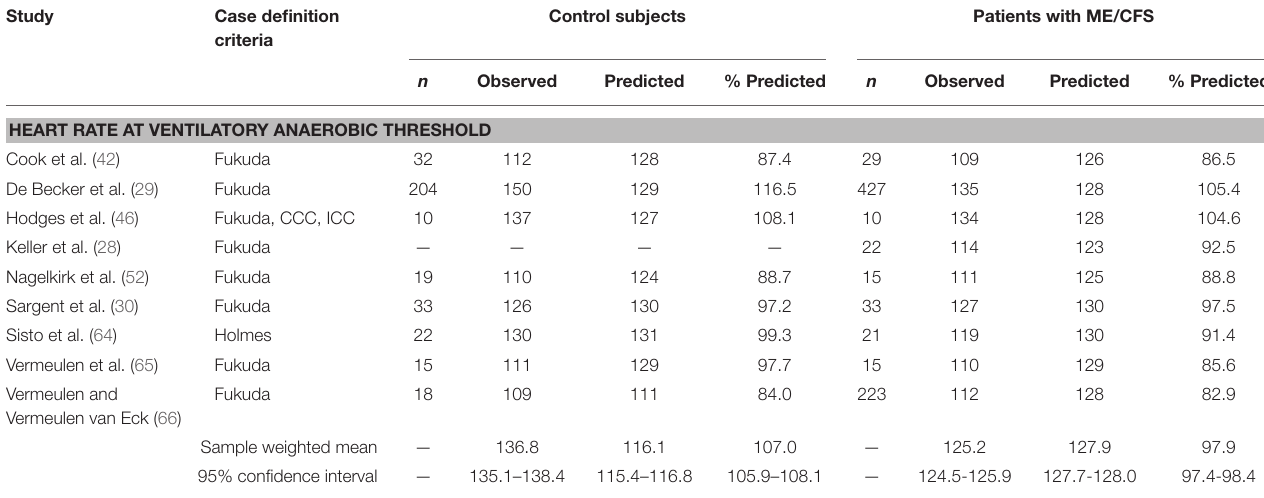
TABLE 2 | Heart rate measurements obtained at ventilatory anaerobic threshold during a single maximal cardiopulmonary exercise test in studies comparing subjects with myalgic encephalomyelitis/chronic fatigue syndrome ( n = 795) to matched control subjects ( n = 353). Study